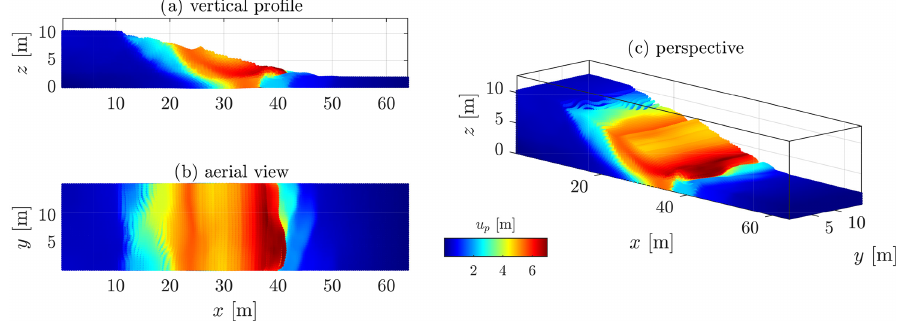
Figure 22. Displacement field obtained after t = 15s for a heterogeneous peak cohesion field with an exponential covariance function.